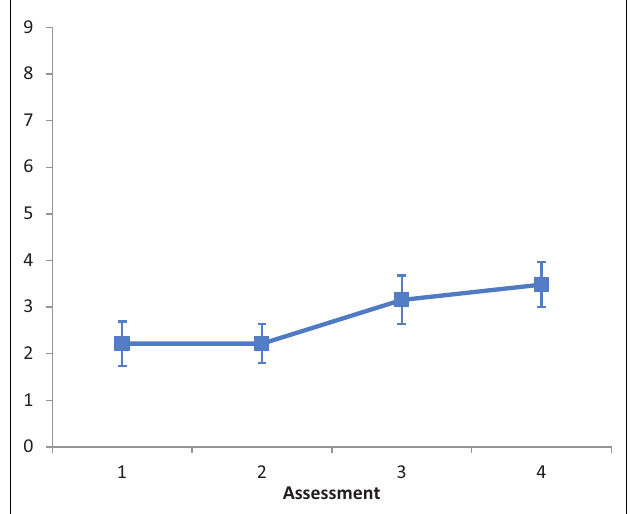
FIGURE 2 | LN patients’ performance on the Picture Scanning subtest as a function of assessment . Error bars represent 1 SEM.